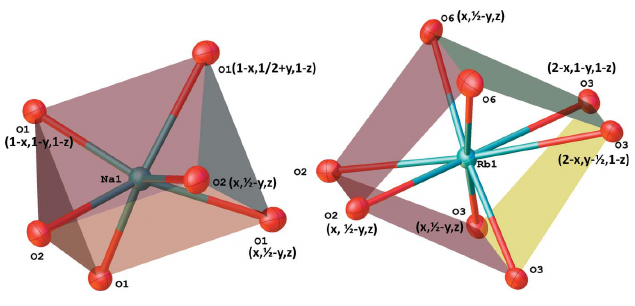
Figure 3 The infinite chains of hydrated sodium (green) and rubidium (purple) ions along the [010] direction. View along [001] vector, with 5 (cid:5) offset.